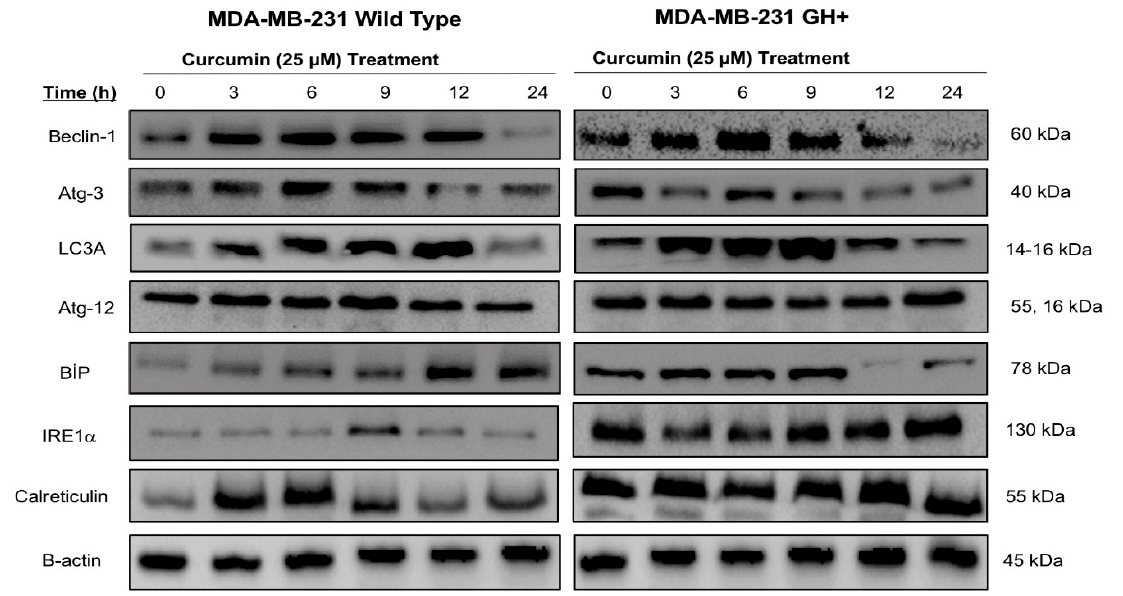
Figure 2. Time-dependent curcumin induced autophagy and ER stress in MDA-MB-231 and T47D wt/GH+ breast cancer cells. The time dependent effect of curcumin on autophagy key players (Beclin- 1, Atg3, Atg12, LC3) and ER stress (BiP, IRE1 α and Calreticulin) molecules expression profile was determined by